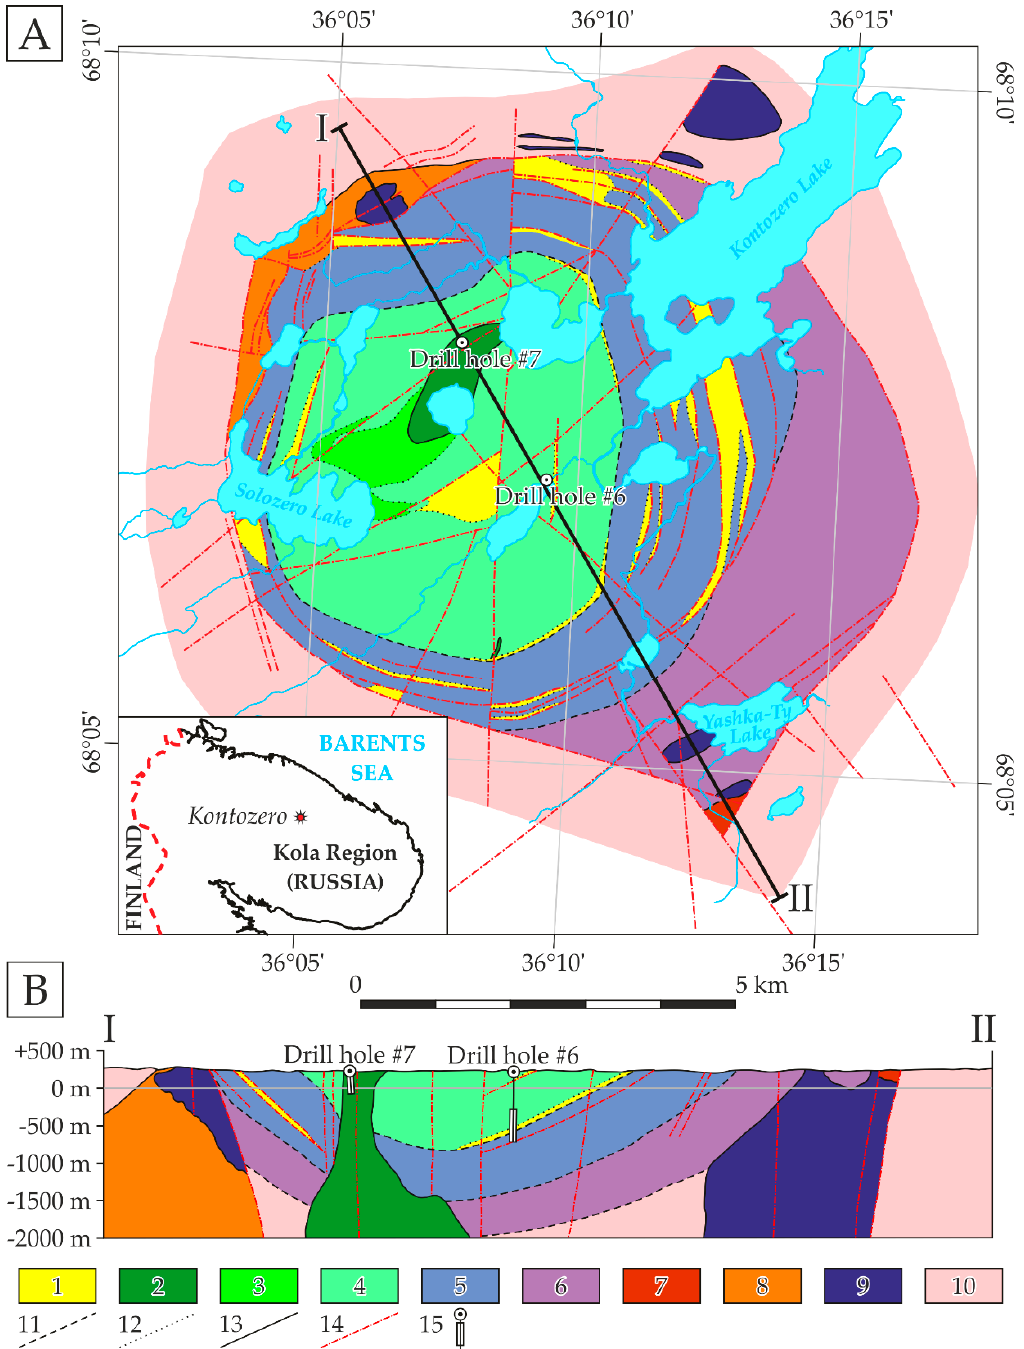
Figure 1. Geological scheme of Kontozero paleocaldera [23]. 1—Zeolite–ankerite–dolomite (± albite) metasomatic rocks; 2—Carbonatite–picrite explosion pipe; (3–6) Kontozero formation: 3—Carbonatite agglomerate tuffs and tuffaceous breccias of vent facies; 4—Carbonatite sequence; 5—Melilitite sequence; 6—Augitite sequence; 7—Terrigenous–volcanic sequence of the Lovozero formation; 8—Alkaline and nepheline syenites; 9—Pyroxenites; 10—Archean gneiss and granite–gneiss; (11–13) Geological boundaries: 11—Between sequences; 12—Between facial varieties; 13—Intrusive; 14—Faults; 15—Drill holes (the rectangles mark the examined intervals). The subfigure shows the location of Kontozero in the Kola region.